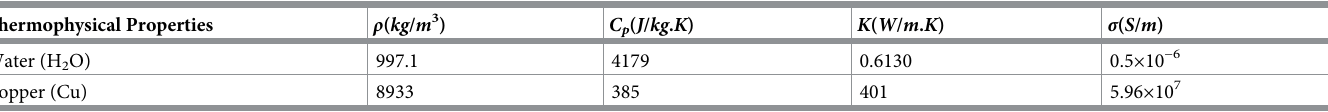
Table 3. Thermo-physical features at 293 K. Thermophysical Properties